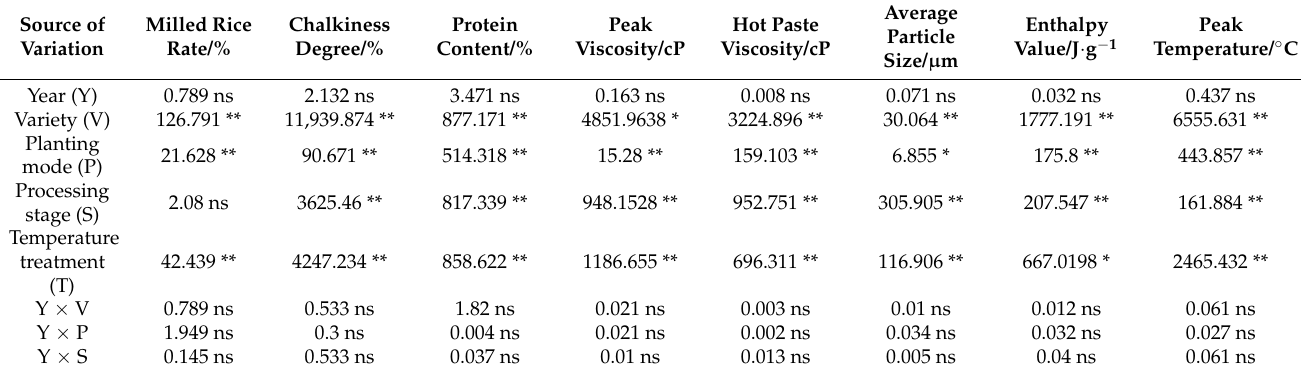
Table 2. Analysis of variance (F-value) for rice quality and starch quality among year, variety, planting mode, processing stage and temperature